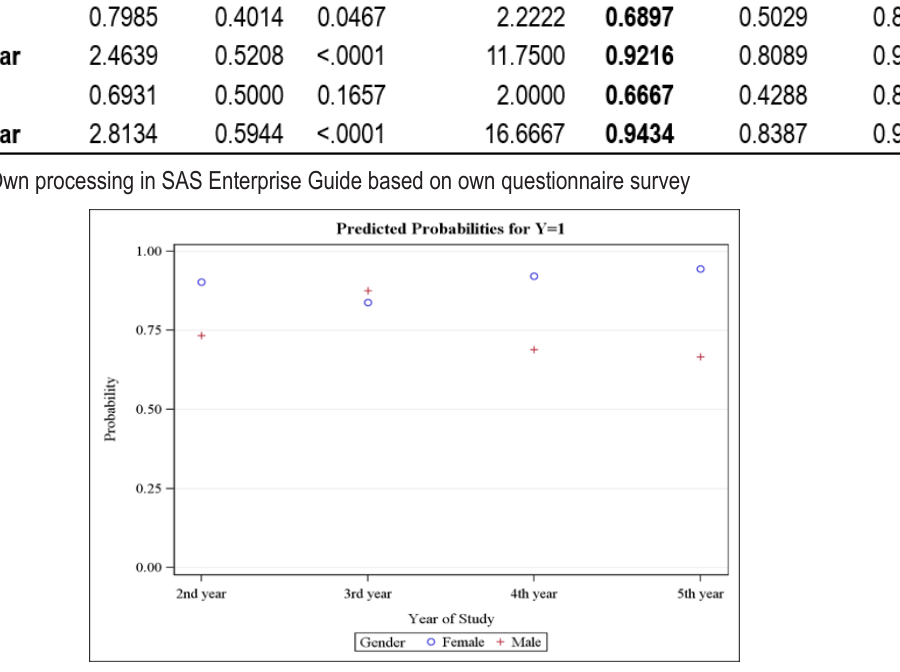
Figure 4. Predicted probabilities that student evaluates quality of educational process in the WT 20/21 at higher quality level than in the ST 19/20 Source. Own processing in SAS Enterprise Guide based on own questionnaire